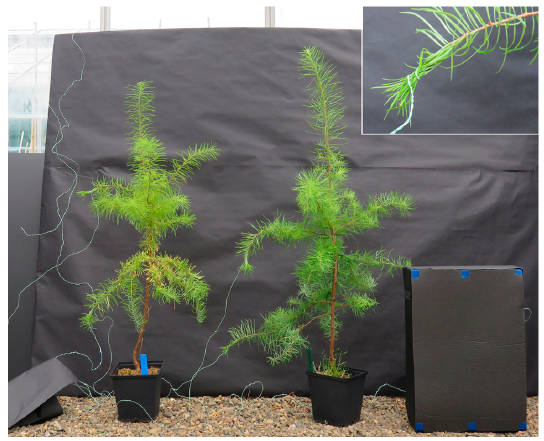
Figure 1. Experiment 1 set-up with calibration target on the right; thermocouples were wrapped inside of needle clumps, as shown on the inset.